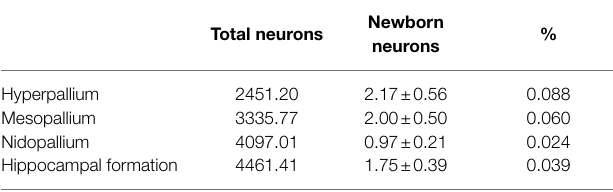
TABLE 2 | Total number of neurons (data from Ströckens et al., 2022, adjusted to mm 2 ) and number of newborn neurons (BrdU+/NeuN+ double labelled cells/ mm 2 ) including their relationship in different telencephalic regions of the pigeon. Newborn Total neurons neurons